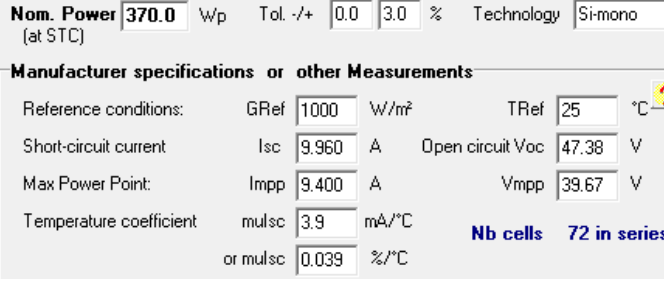
Figure 6. Solar panel specifications.